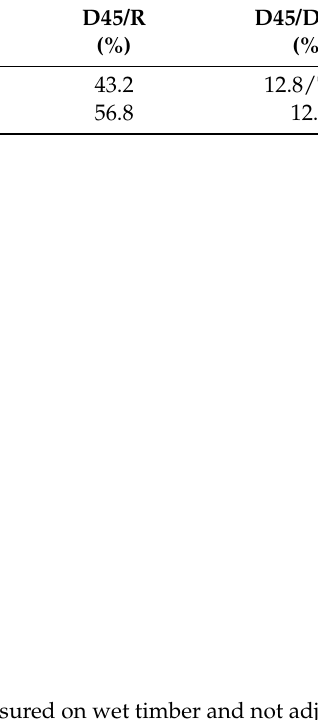
Figure 5. Scatterplot of density vs. velocity measured on wet timber and not adjusted for moisture content. Vertical lines = settings recalculated at 40% MC for D35 (grey) and D45 (black); horizontal lines = characteristics values of density for the classes D35 (grey) and D45 (black); sparse oblique lines = pieces assigned to D35; dense oblique lines = pieces assigned to D45. 4. Conclusions Machine strength grading was verified to be possible and can be effectively applied to round timber, mostly with the same rules used for the squared assortments. The settings developed in the present work should be considered merely demonstra- tive due to the insufficient initial sampling (less than the number required by the technical standardization). However, the calculations and verifications required by the machine